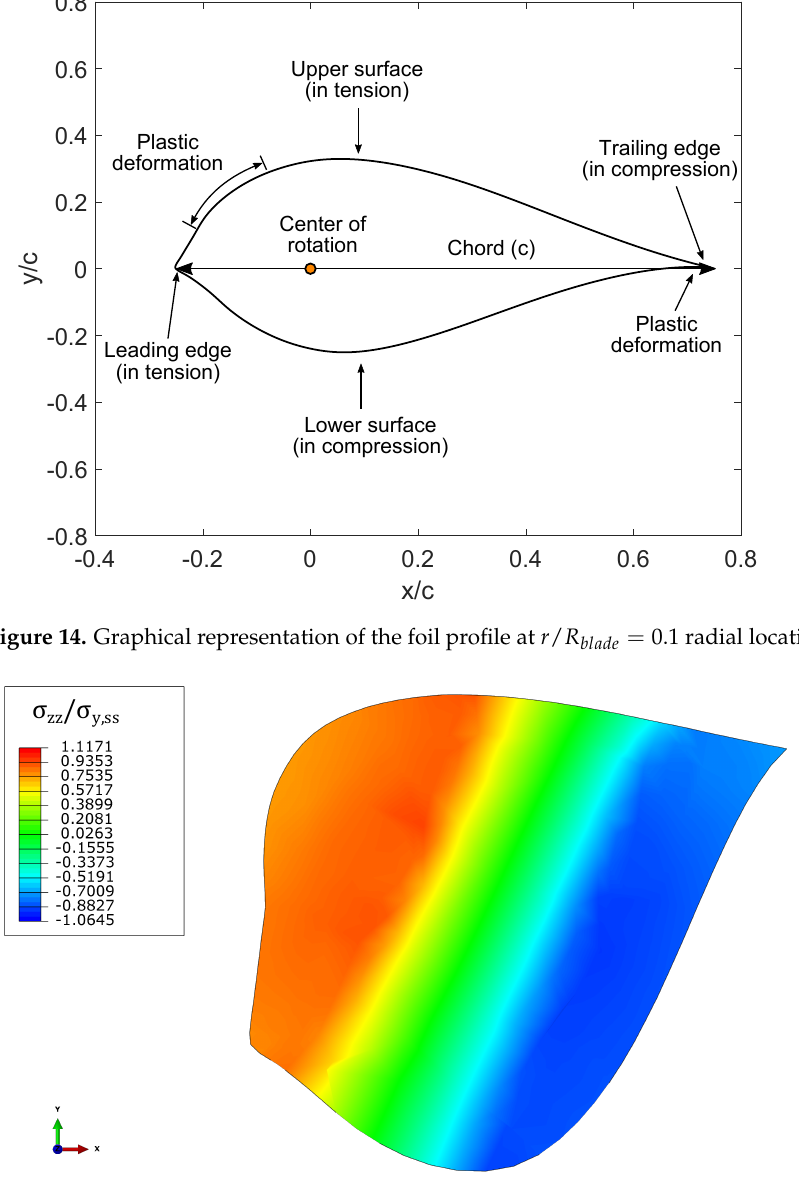
Figure 15. Visualization of the normalized bending stress ( σ zz / σ y , ss ) of the foil profile at r / R blade = 0.1 radial location, in case of normalized velocity of the killer whale at x -direction ( v x / v 1 ) equal to 5.35; v y = 1